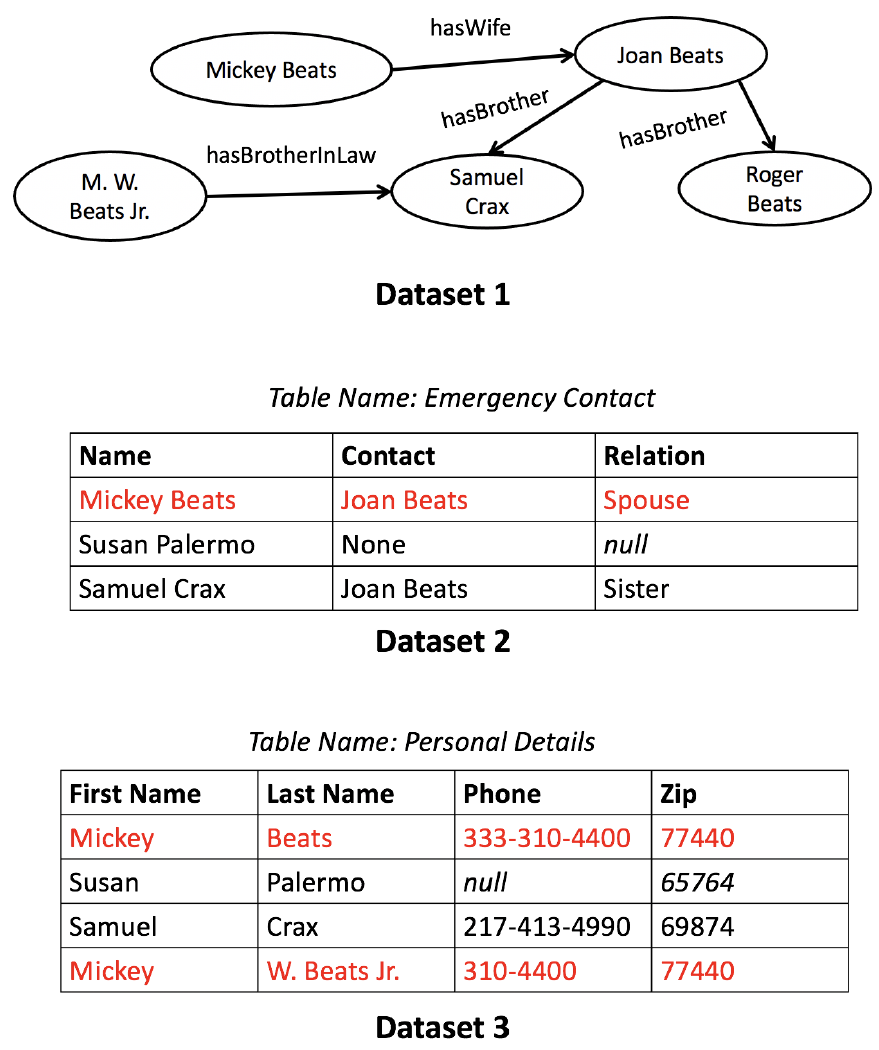
Figure 3. Three example datasets exhibiting various kinds of heterogeneity. Dataset 1 is a knowledge graph (KG) that could be represented using RDF (for example), while the other two datasets form a pair of structurally heterogeneous